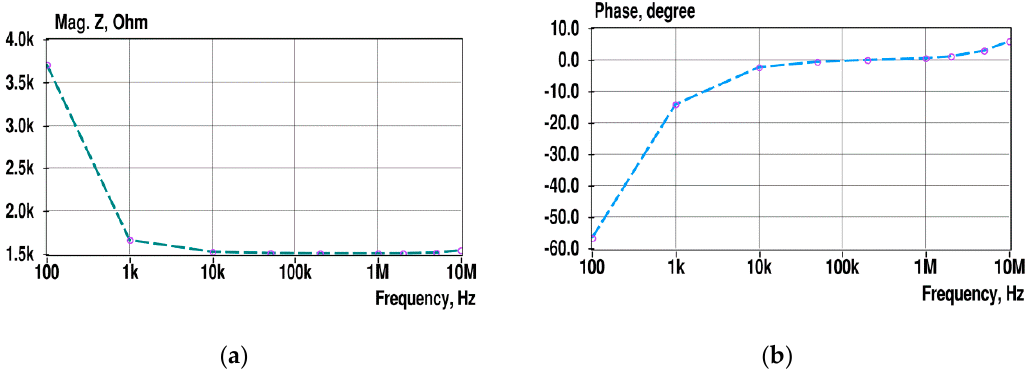
Figure 20. Mean magnitude ( a ) and phase ( b ) spectra of the PBS solution measured with “Platypus” sensors described in Section 4.3. Ring-shaped marks indicate the used frequencies.